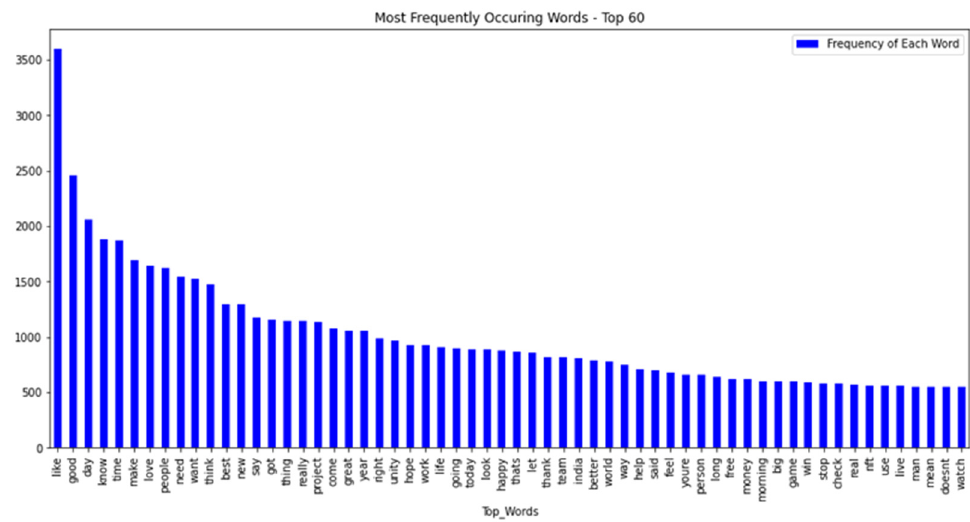
Figure 2. Sixty most frequently appearing words in the considered datasets.